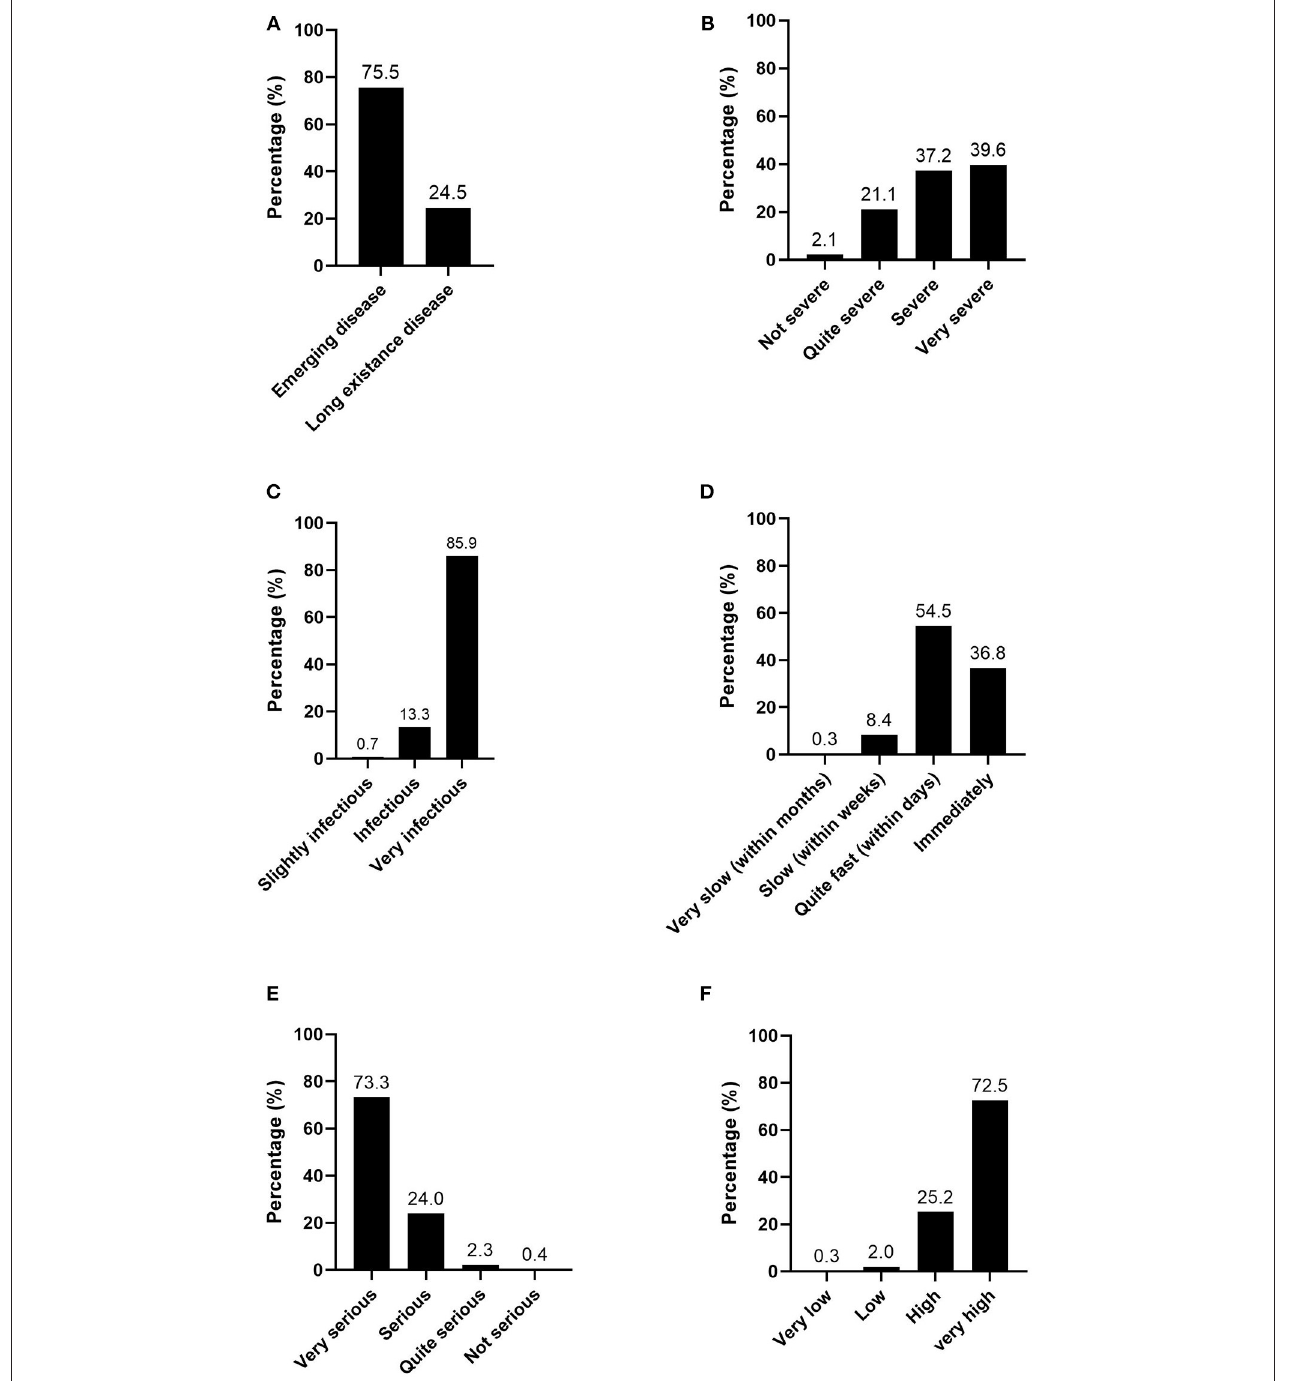
FIGURE 2 | Perception on: (A) Newness; (B) Severity; (C) Infectiousness; (D) Contagiousness; (E) Seriousness; and (F) Total cases of COVID-19 in Indonesia ( n = 1,043).